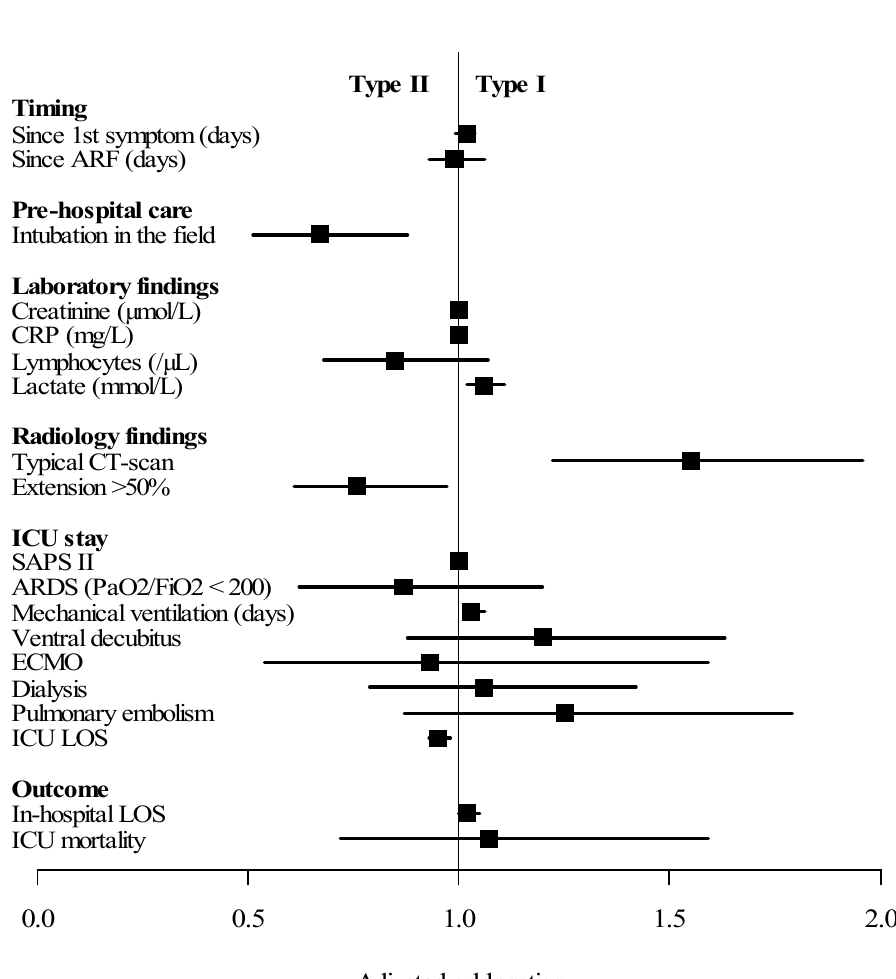
Figure 1. Multivariate analysis of factors associated with the difference between Type 1 and Type 2 clinical profiles. Type 1 is defined in our study as “silent/happy” hypoxemia without symptoms of ARF. Type 2 corresponds to patients who have both hypoxemia and clinical ARF. Abbreviations: ID = immunodeficiency, min = minute, L = liter, ARF = acute respiratory failure (clinical), EMS = emergency medical services (medicalized), CRP = C-reactive protein, CT = computed tomography, ICU = intensive care unit, LOS = length of stay, ARDS = acute respiratory distress syndrome, ECMO = extracorporeal membrane oxygenation, SAPS II = Simplified Acute Physiology Score II.